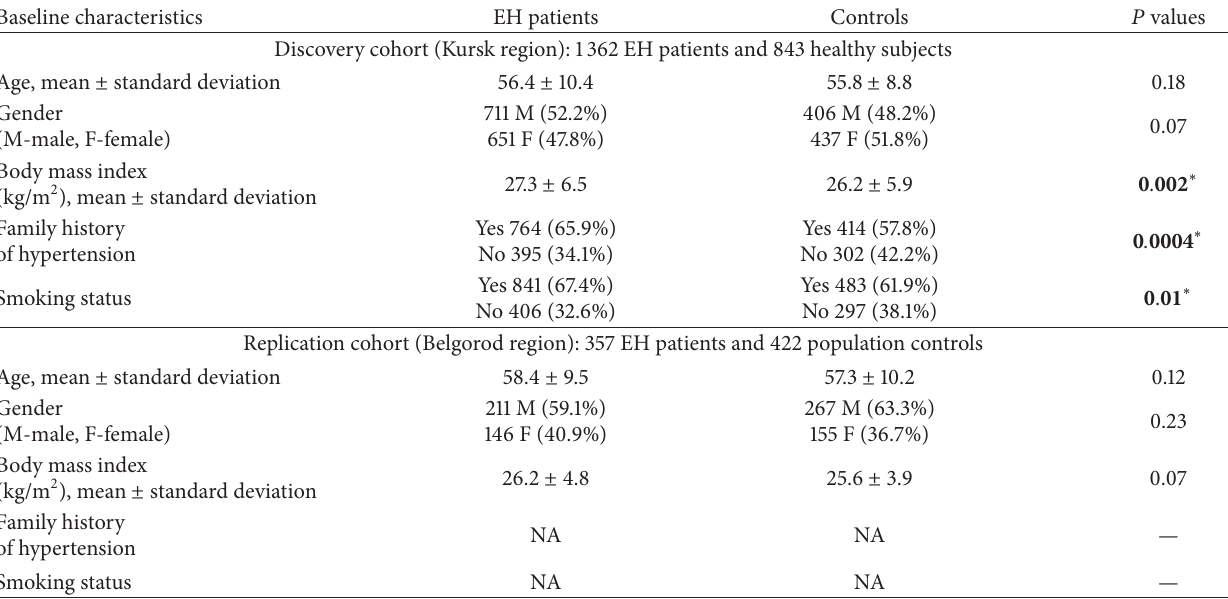
Table 1: Baseline characteristics of two study